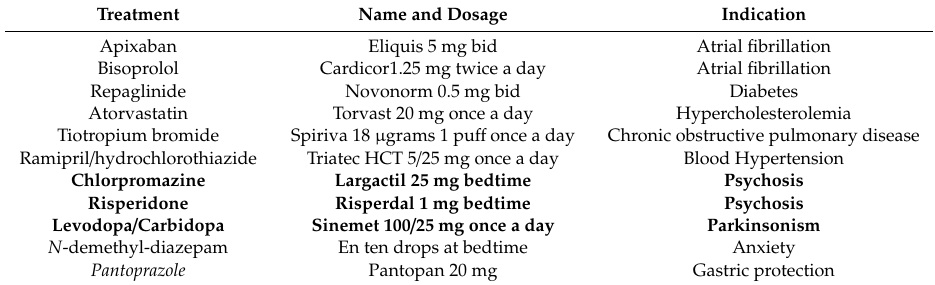
Table 1. Description of drugs administered to our patient. Inappropriate drugs are in bold (see explanationinthesectiondiscussion). Pantoprazoleisreportedinitalics(seethe sectiondiscussion).